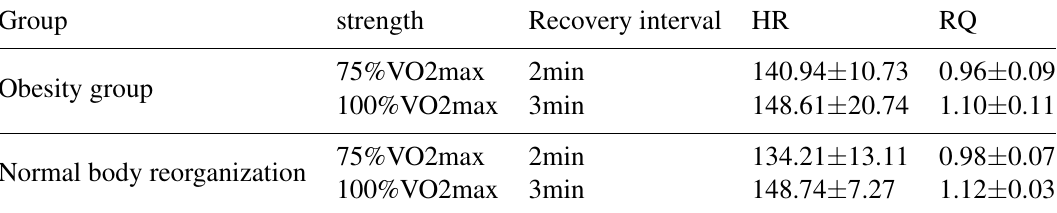
Table 2 Intermittent recovery of terminal heart rate during intermittent